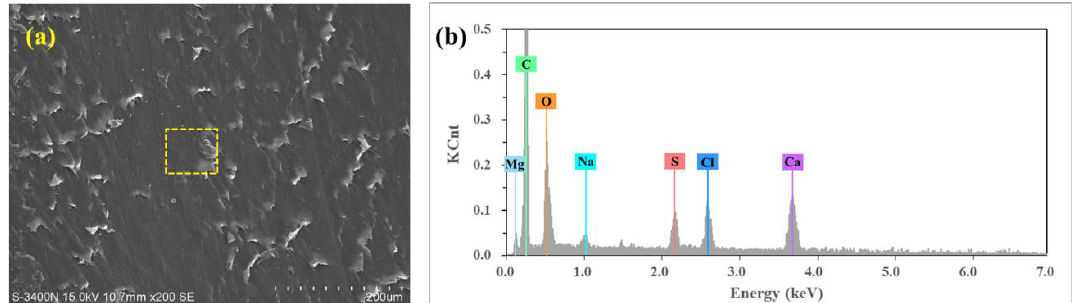
Figure 10. EDS analysis of worn surface of UHMWPE under brine-unsaturated lubrication with 1100 r/min speed, where ( b ) is EDS spectra of the sample surface labeled in ( a ).